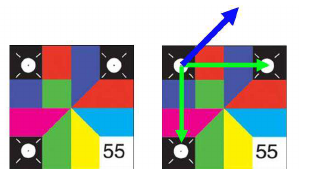
Figure 3. Color-coded target: the different color patterns of the coded target are used for the identification; a single coded target features three circular signalized points. Right: the normal vector can be calculated by the measured three signalized points.